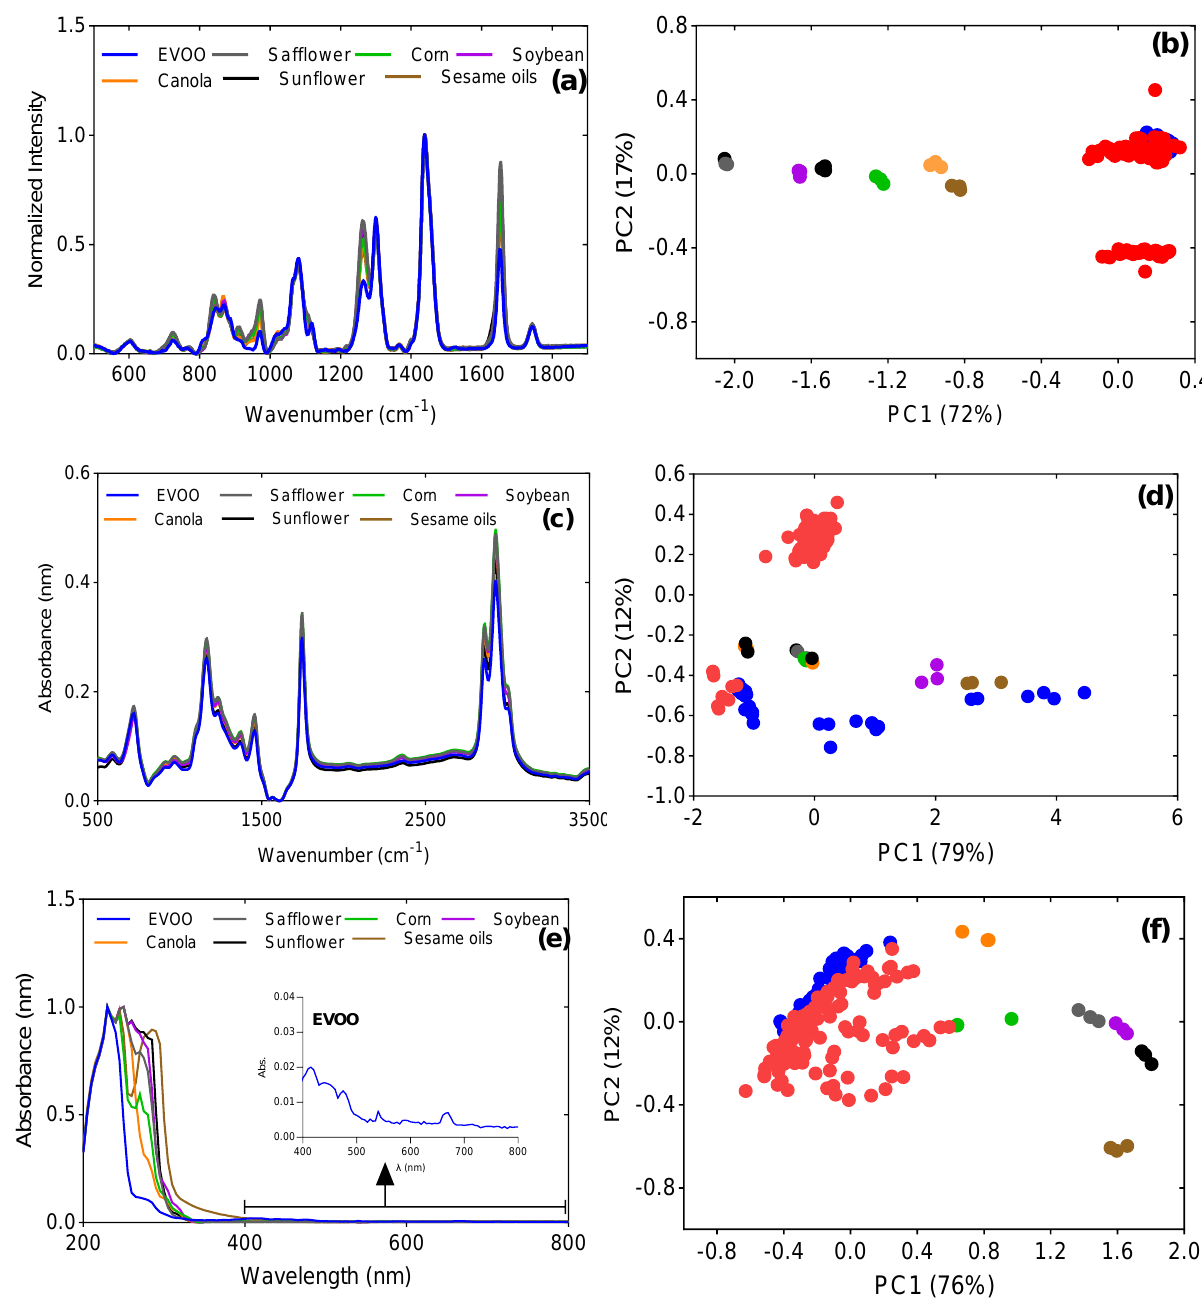
Figure 4. ( a ) Raman spectra of EVOO and other vegetable oils; ( b ) Raman PC plot showing the relationship between EVOO, other vegetable oils and adulterated olive oil; ( c ) Typical mid − infrared FTIR raw spectra for EVOO and other edible oils; ( d ) FTIR PC plot; ( e ) UV − Vis spectra of EVOO and other vegetable oils; ( f ) UV − Vis PC scores plot. Groups on the PC plots: • EVOO; • safflower oil; • corn oil; • soybean oil; • canola oil; • sunflower oil; • sesame oil; • adulterated olive oil. From the PC scores plot in Figure 4b, PC1 and PC2 accounted for 89% of the total variance for Raman spectral data. Based on the PC loadings (Figure S1), vibrations at wavenumbers 1656 cm − 1 (C=C stretching), 1263 cm − 1 (=C–H bending), 1106 cm − 1 (C–C stretching) and 970 cm − 1 (C=C bending) contributed to the information in PC1 that dis- tinctly separated the cheaper vegetable oils (adulterants) from EVOO [3]. Due to EVOO being low in polyunsaturated fatty acids, it exhibited low Raman intensities at these